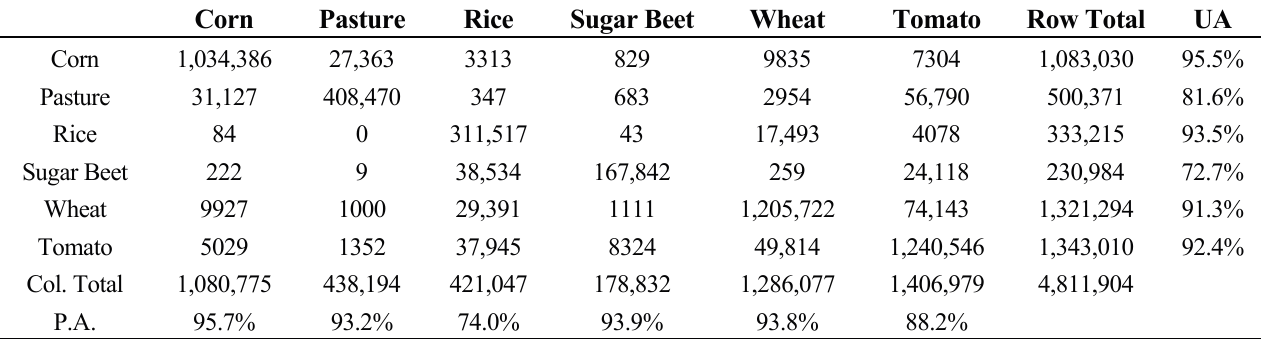
Figure 9. ( a ) QuickBird test image (RGB, 4,666 × 3,873 pixels, acquired on 13 August 2004), and the ( b ) reference map. Thematic output maps of, ( c ) SVM without smoothing, ( d ) SVM-LCS, ( e ) SVM-ECS, and ( f ) parcel-based strategy with SVM without smoothing. Table 3. Confusion matrix of SVM-ECS classification for QuickBird test image.